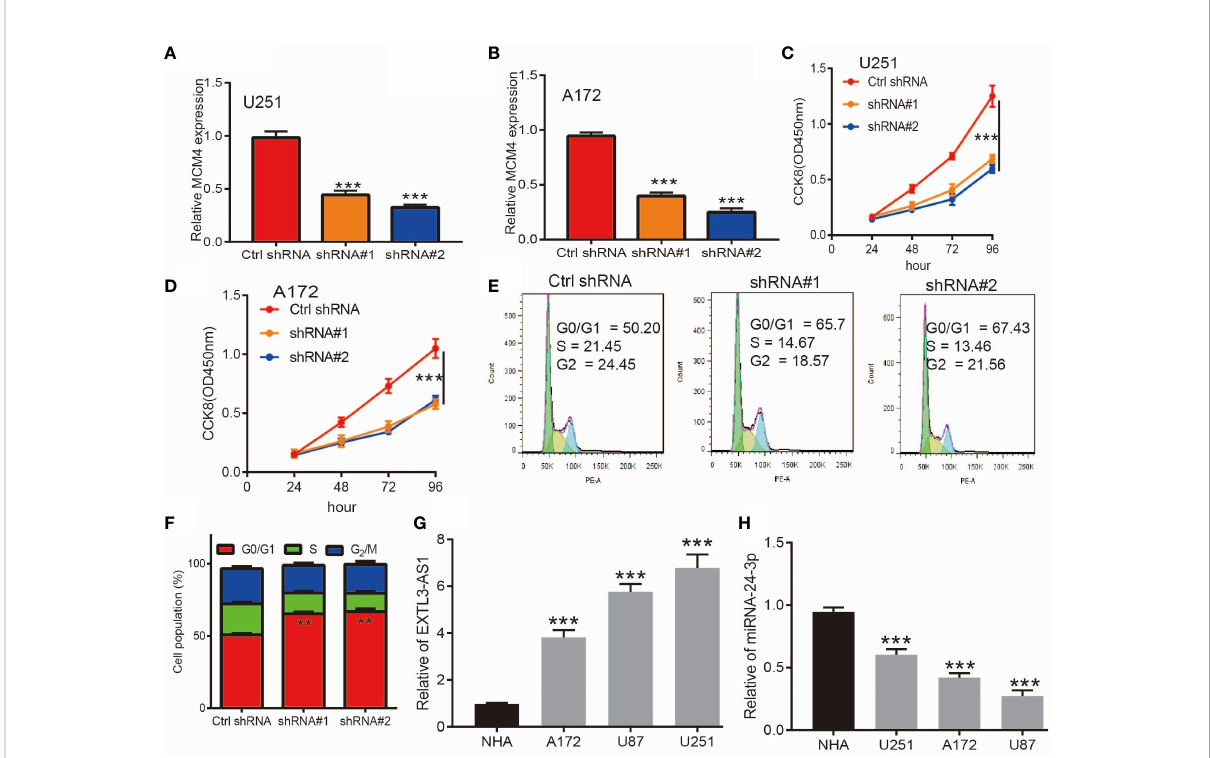
FIGURE 13 Knockdown of MCM4 inhibits glioma cell proliferation. (A, B) The knock-down ef fi ciency of MCM4 in glioma cell lines was examined by qRT- PCR assay. (C, D) Depletion of MCM4 inhibits glioma cell proliferation examined by CCK-8 assay. (E, F) Depletion of MCM4 increased G0/G1 phase arrested cells. (G, H) The expression of EXTL3-AS1 and miRNA-24-3p in glioma cell lines was examined by qRT-PCR assay. shRNA#1=MCM4 shRNA#1, ShRNA#2=MCM4 shRNA#2. **p < 0.01, ***p <